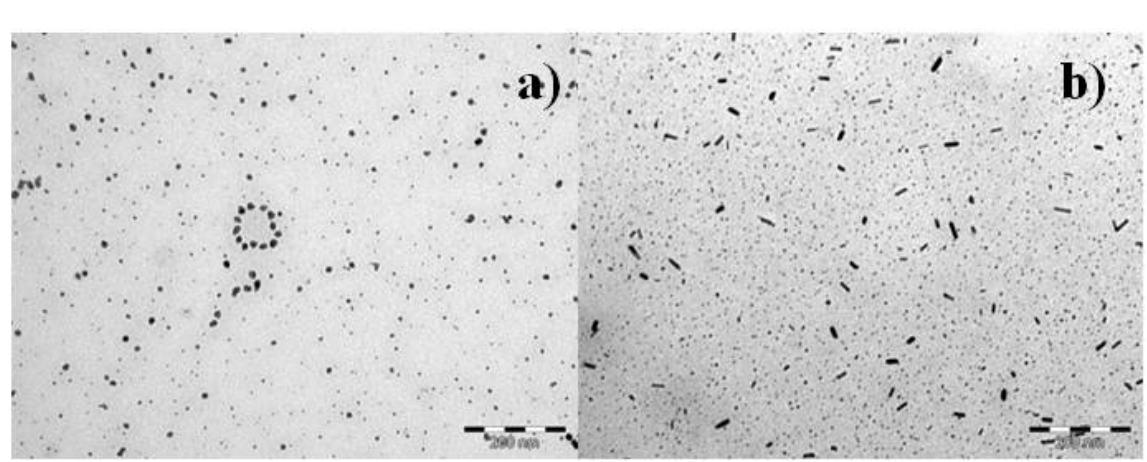
Figure 5. Co nanoparticles obtained with P41Boba polymer after 17 h at 120 °C for ( a ) Boba:HDA:Co = 0.65:1:1 (1.25 wt% Co); ( b ) Boba:HDA:Co = 0.16:1:1 (4 wt% Co). Scale bars: 200